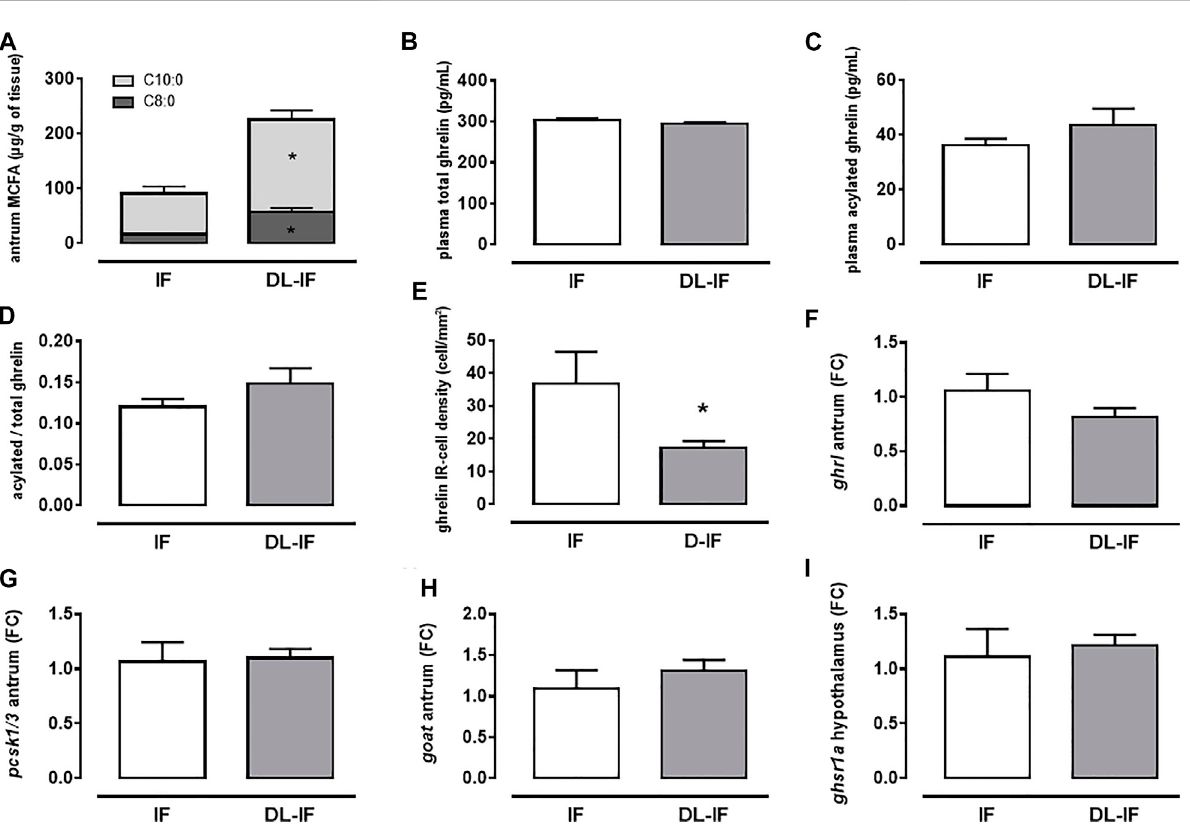
FIGURE 3 ImpactofdietaryMCFAformulaontheghrelinsystem.Mediumchainfattyacids(MCFA,C8:0,andC10:0)contentintheantrum (A) ,total (B) and acylated (C) ghrelin plasma level, plasma acylated-to-total ghrelin ratio (D) , density of acylated ghrelin immuno-reactive (IR) cells in the antrum (E) , pre-pro-ghrelin ( ghrl ) (F) , convertase 3 ( pcsk 1/3) (G) and ghrelin-O-acetyl transferase ( goat ) (H) mRNA levels in the antrum and ghrelin receptor ( ghsr1a ) mRNA levels in the hypothalamus (I) were measured in mini-piglets fed infant formulas formulated with plant lipids (IF) or with a mix of plant and dairy lipids (DL-IF) to modulate MCFA dietary levels. Data are means +/ − sem. *: p ≤ 0.05, Student t -test ( n = 5 and 11 for IF and DL-IF